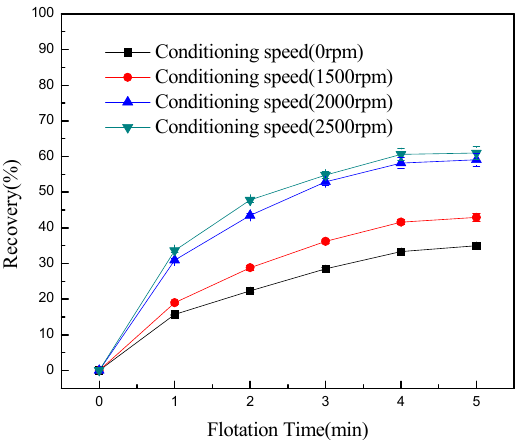
Figure 8. Effect of conditioning speed under nitrogen atmosphere on the recovery of mixed minerals, with pyrrhotite and chlorite mixed at a ratio of 10:1 (pH = 9.0 ± 0.2; C(potassium amyl xanthate) = 1 × 10 − 4 mol/L; C(MIBC) = 1 × 10 − 4 mol/L; and Conditioning time = 5 min).